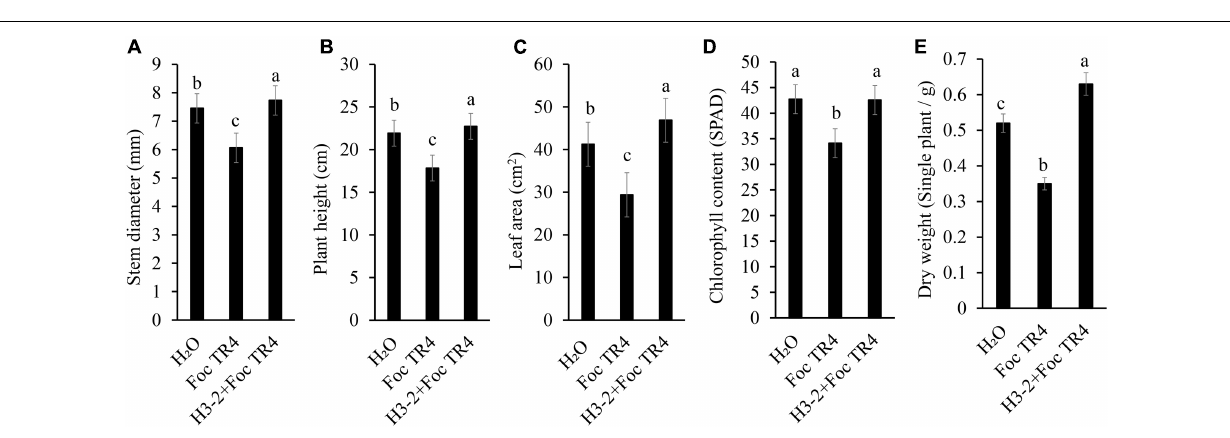
FIGURE 9 | Effect of the strain H3-2 fermentation broth on the growth of banana seedlings. Growth parameters including stem diameter (A) , plant height (B) , leaf area (C) , chlorophyll content (D) , and dry weight (E) were measured. Different lowercase letters indicate a significant difference at the level of p <